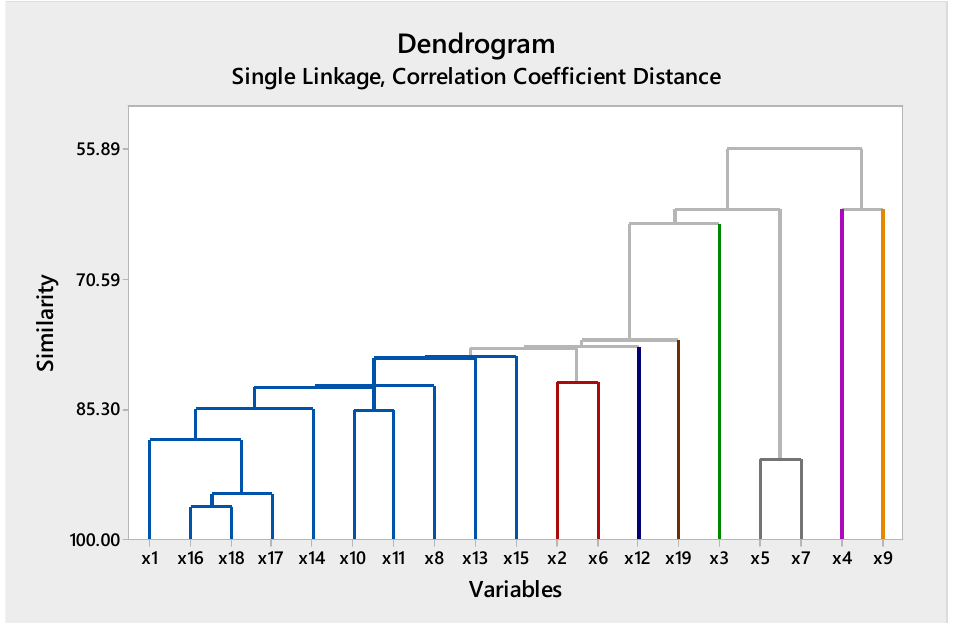
Table 2. Clusters content when the number of clusters is equal to eight (N = 8) .